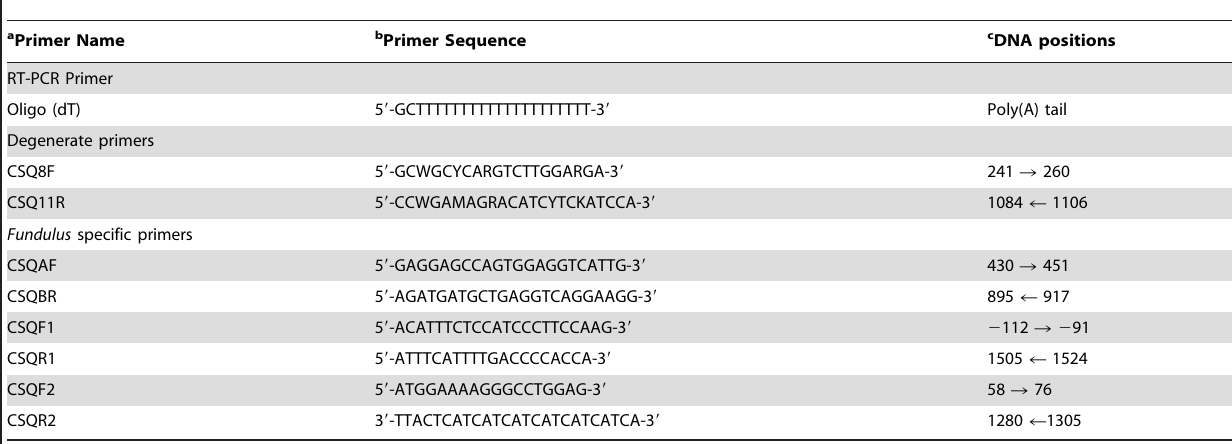
Table 1. Primers used for amplification of Fundulus heteroclitus CSQ